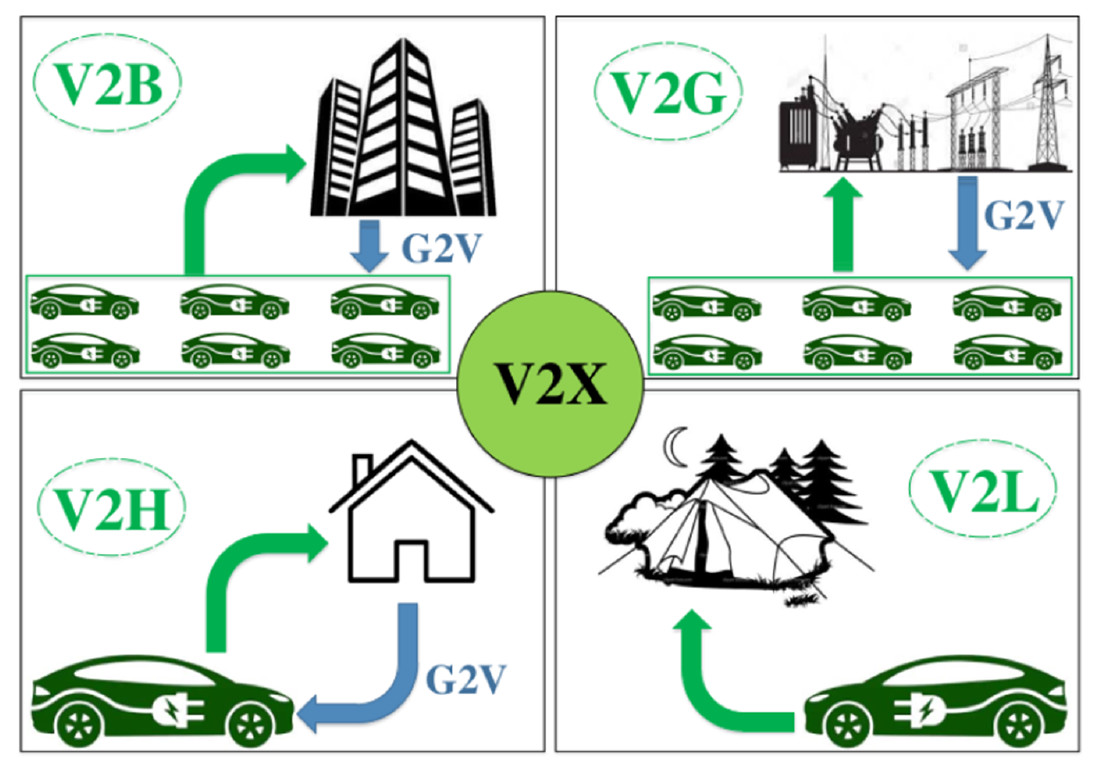
Figure 5. The topology of V2X technology.